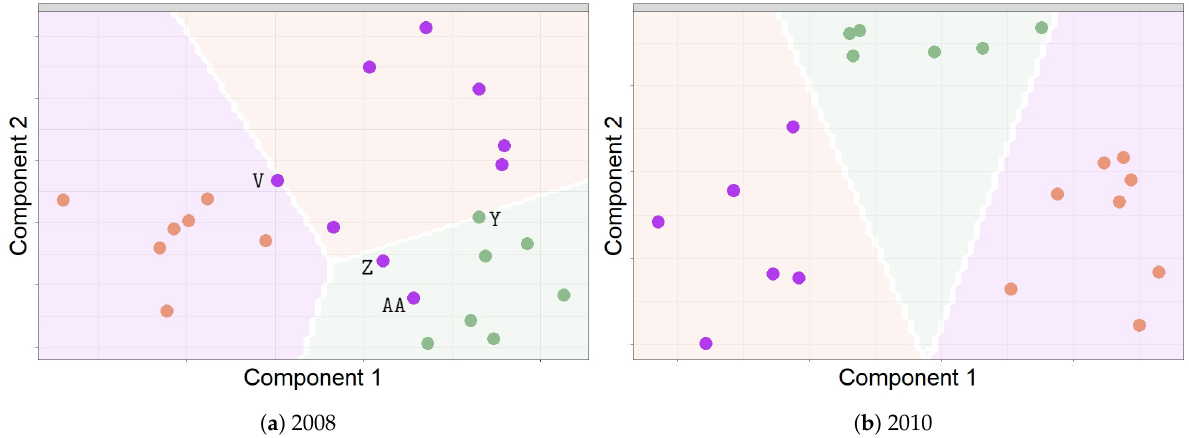
Figure 11. Prediction classes derived from M3: these plots display the predicted classes of each sensor located in different points in a simulated grid. The final classification prediction for the position of the sensors is displayed. The points in orange ( RC ), purple ( W ) and green ( F ) represent the class prediction for the sensors in the study. ( a ) For 2008: according to the classification prediction, the wrongly classified sensors were as follows: V , Y , Z , and AA . ( b ) For 2010: all sensors were classified